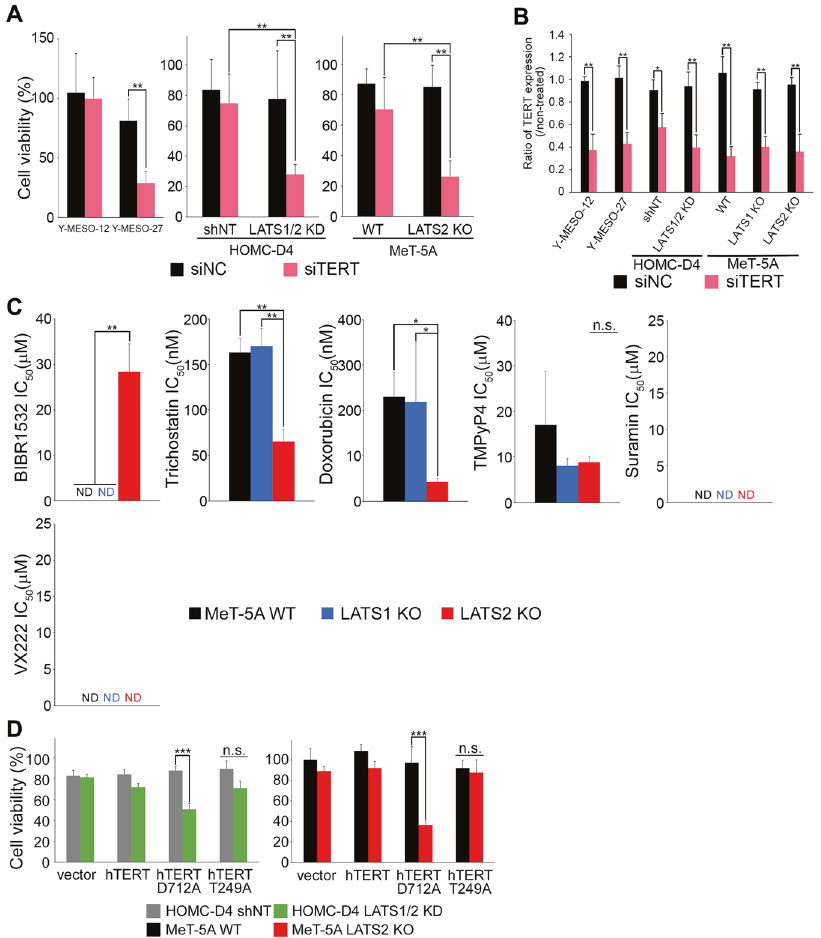
Fig. 5 Inactivation of LATS2 and inhibition of TERT show a synthetic lethal phenotype, requiring RdDP activity of TERT. A Each cell was transfected with siTERT. Cell viability was measured after 144 h of siTERT treatment using CCK-8. B The knockdown ef fi ciency of TERT. mRNA was collected after 72 h of siTERT treatment. C The IC 50 of the TERT inhibitors (BIBR1532, trichostatin, doxorubicin, TMPyP4, suramin, and VX222) in MeT-5A (WT, LATS1 KO, and LATS2 KO). The diluted TERT inhibitor was applied to each cell, and cell viability was measured after 144 h of incubation using CCK-8. D hTERT D712A- and hTERT T249A-overexpressing plasmids were transfected into HOMC-D4 (non-target [shNT] and LATS1/2 KD) and MeT-5A (WT and LATS2 KO) cells. The cell viability was measured after 144 h of transfection using CCK-8. All experiments were performed at least three independent times. Data are presented as means ± SD, and p values were calculated using the Tukey-Kramer method. * indicates p < 0.05, ** indicates p < 0.01 and *** indicates p < 0.001. n.s. - no signi fi cant